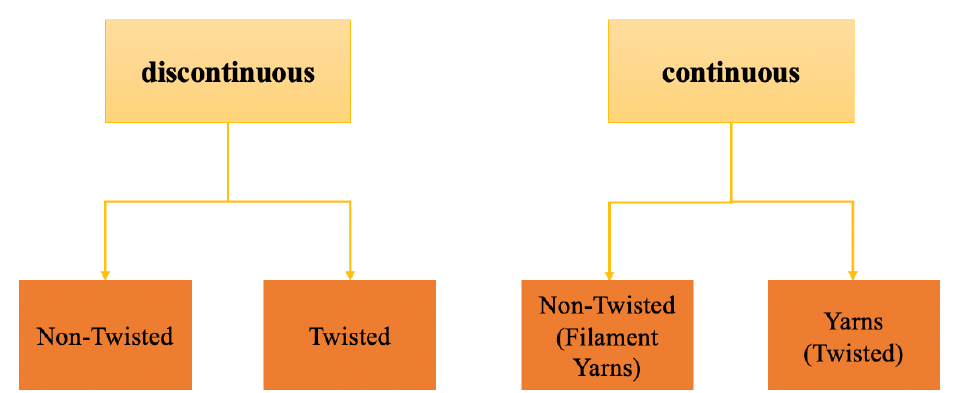
Figure 1. Nanofiber bundle categories. Adapted from ref.